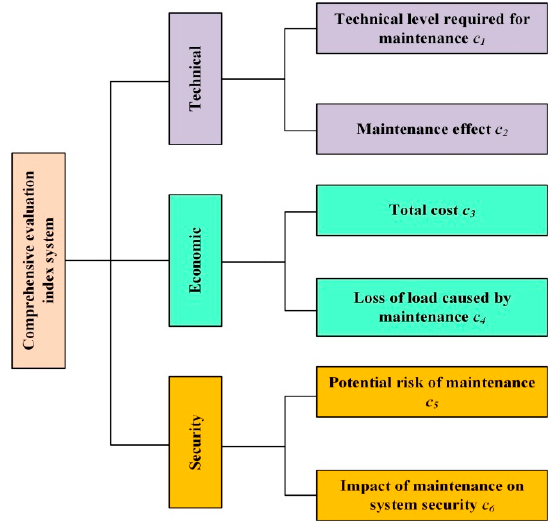
Figure 1. The comprehensive evaluation index system .